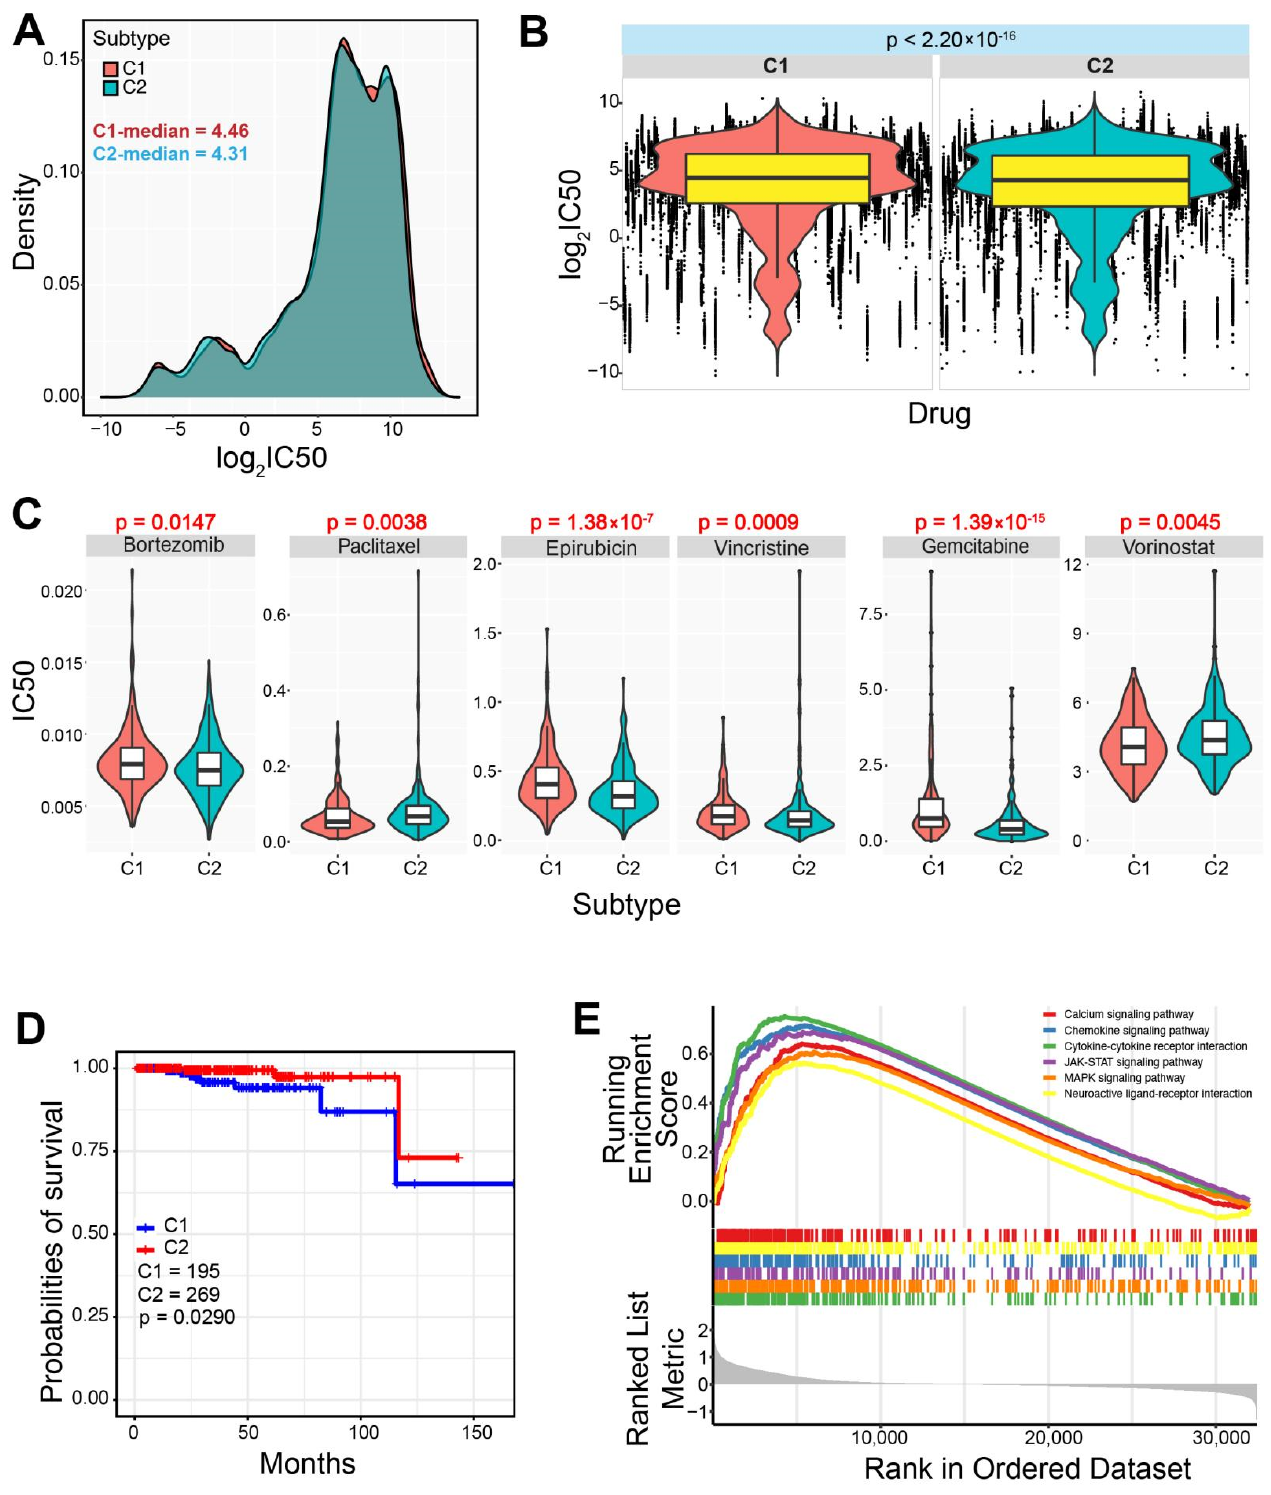
Figure 4. Drug response analysis between the two screened subtypes in PRAD. ( A ). The distributions of the IC50 values between the two subtypes, and the median values are also presented. ( B ). The detailed distributions of the IC50 values between the two subtypes ( p < 2.2 × 10 − 16 is estimated using the trend test). ( C ). Several drugs show significant differences of IC50 values between the two subtypes. ( D ). Survival analysis shows distinct survival outcomes between the two subtypes. ( E ). Gene set enrichment analysis (GSEA) of the dysregulated genes in the C2 compared with those in the C1 subtype indicates significantly enriched several biological